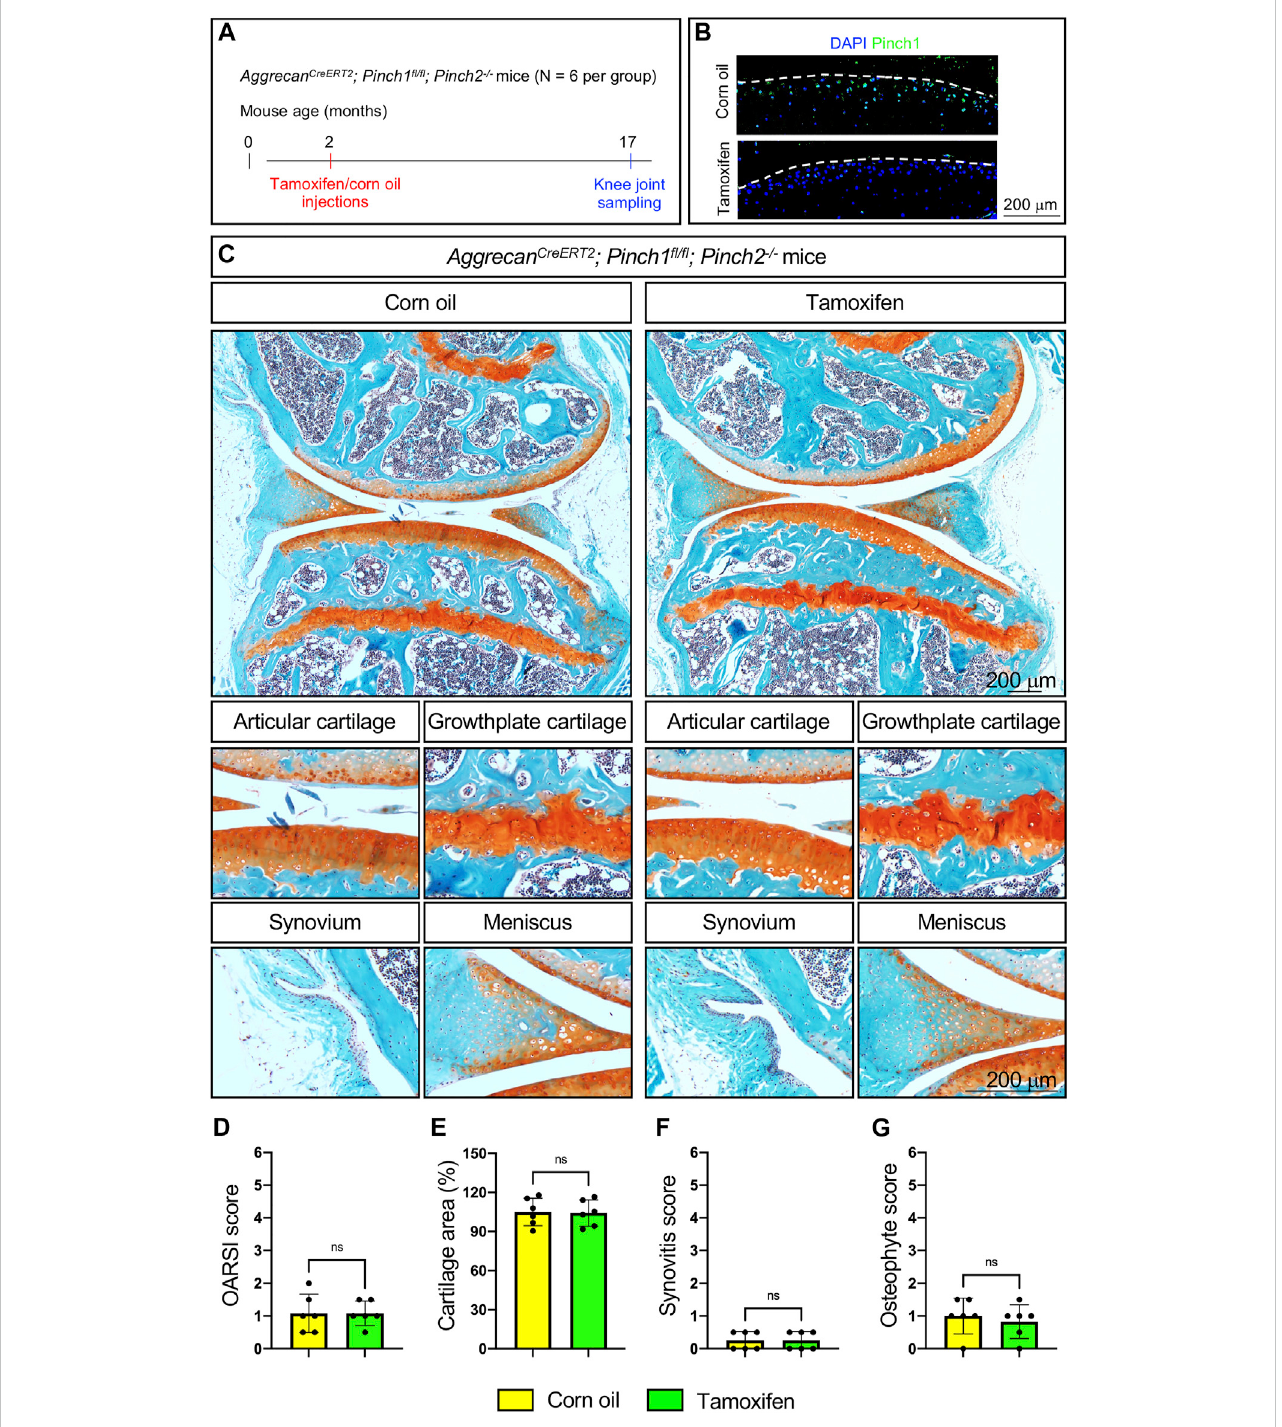
FIGURE 3 Pinch1/2 loss does not promote OA defects in aged mice. (A) A schema illustrating the experimental design. (B) Immuno fl uorescence staining of Pinch1inarticularcartilage.Scalebar:200 μ m. (C) RepresentativesafraninOandfastgreen-stainedimagesofkneejointsectionsfromtamoxifen-orcornoil- treated Aggrecan CreERT2 ; Pinch1 fl ox/ fl ox ; Pinch2 − / − mice at 17 months of age. Higher magni fi cation images in lower panels are showing the areas of articular cartilage, growth-plate cartilage, synovium, and meniscus. Scale bar: 200 μ m. (D – G) Quantitative histological analyses of OARSI score, cartilage areas, synovitisscore,andosteophytescoreusingkneejointsections.Note:N=6miceforeachgroup.Resultsareexpressedasmean±standarddeviation(s.d.).ns: not signi fi